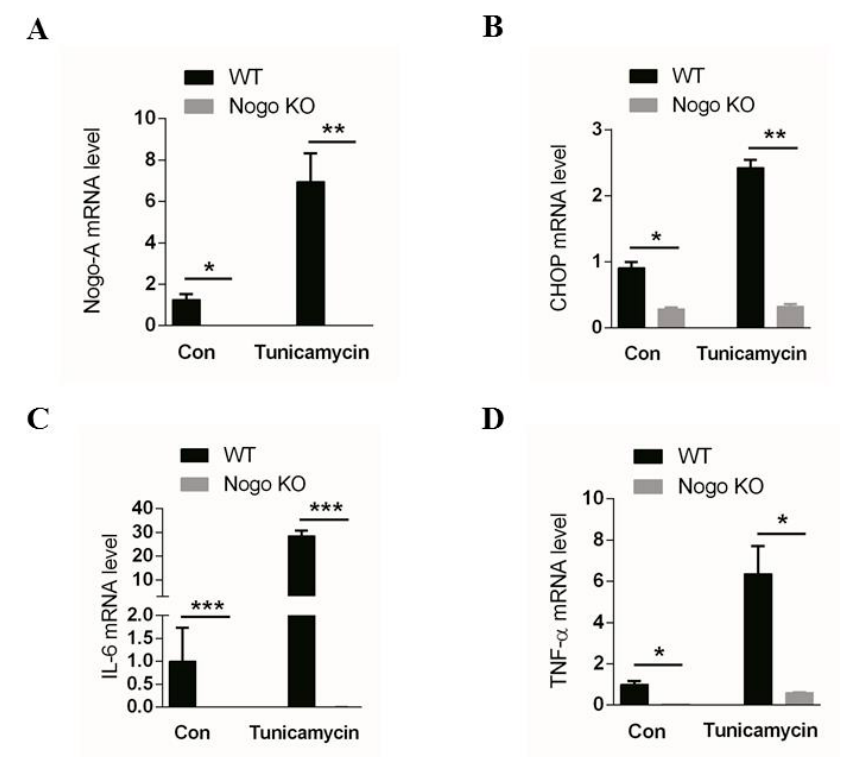
Figure 6. Tunicamycin-induced endoplasmic reticulum (ER) stress was mediated by the Nogo-A-CHOP pathway. ( A ) The Nogo-A expression level is upregulated in the skeletal muscle of tunicamycin-treated WT mice compared with Nogo-KO mice. ( B ) CHOP is highly expressed in tunicamycin-treated skeletal muscle of WT mice compared with Nogo-KO mice. ( C , D ) IL-6 and TNF- α are highly expressed in skeletal muscle of tunicamycin-treated WT mice compared with skeletal muscle of Nogo-KO mice. Data are shown as the mean ± standard error of the mean. Statistical significance was determined using Student’s t -test. Data are denoted by asterisks where * p < 0.05, ** p < 0.01, *** p < 0.001.